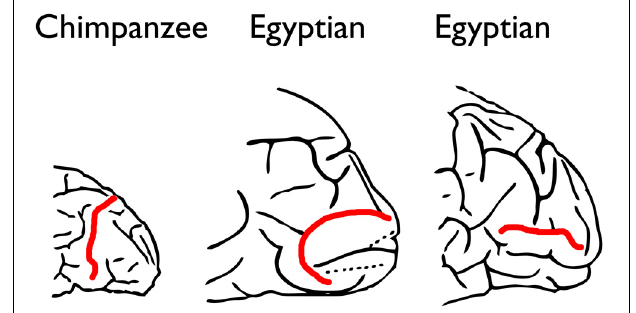
FIGURE 1 | The Affenspalte of a typical chimpanzee brain compared with sulci in human brains that Grafton Elliot Smith identified as homologs of the Affenspalte. Because Smith thought the name Affenspalte (“ape sulcus”) was inappropriate for humans, he changed it to “lunate sulcus” to be more inclusive. The illustrations represent posterior ends of left hemispheres, and the Affenspalte and so-called lunate sulci are in red. The middle and right figures are modified from Smith (1903, pp. 75 and